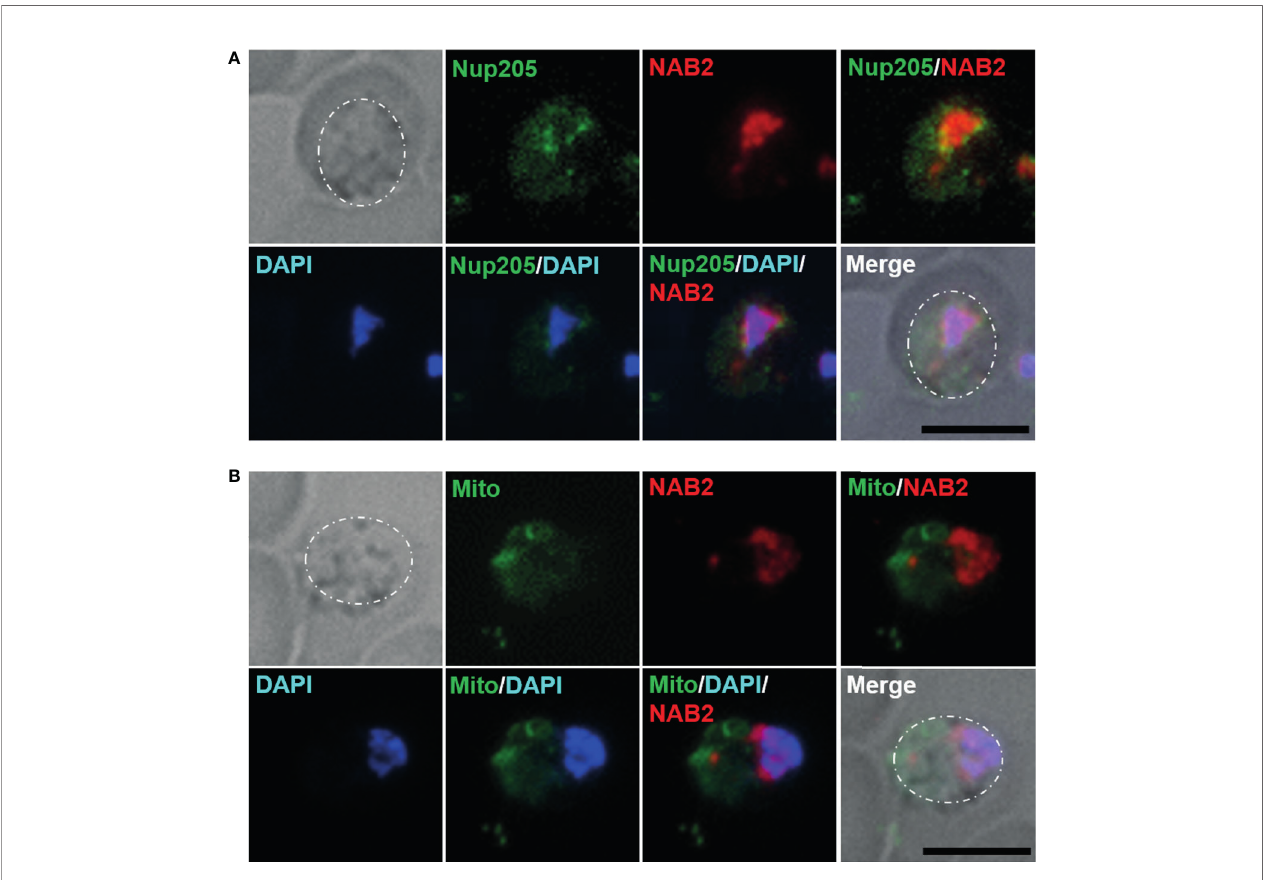
FIGURE 3 | Cellular localization of NAB2 in P. berghei ANKA. Female B6 mice were infected with 5 × 10 6 to 5 × 10 7 schizonts of transgenic P. berghei ANKA expressing the NAB2 – mCherry fusion protein (NAB2::mCherry) or NAB2::mCherry parasites expressing NUP205 fused to GFP. Erythrocytes infected with malaria parasites at 18 h (late trophozoite) after inoculation were analyzed. At least 50 infected erythrocytes were analyzed, and the same fl uorescence pattern was observed in all infected erythrocytes. (A) NAB2::mCherry parasites expressing NUP205 fused to GFP. P. berghei ANKA during the late trophozoite stage are shown. (B) MitoBright LT Green-stained NAB2::mCherry parasites. P. berghei ANKA during the late trophozoite stage are shown. Scale bar = 5 µm. Dotted lines indicate malaria parasites. Experiments were performed in triplicate. Representative data are